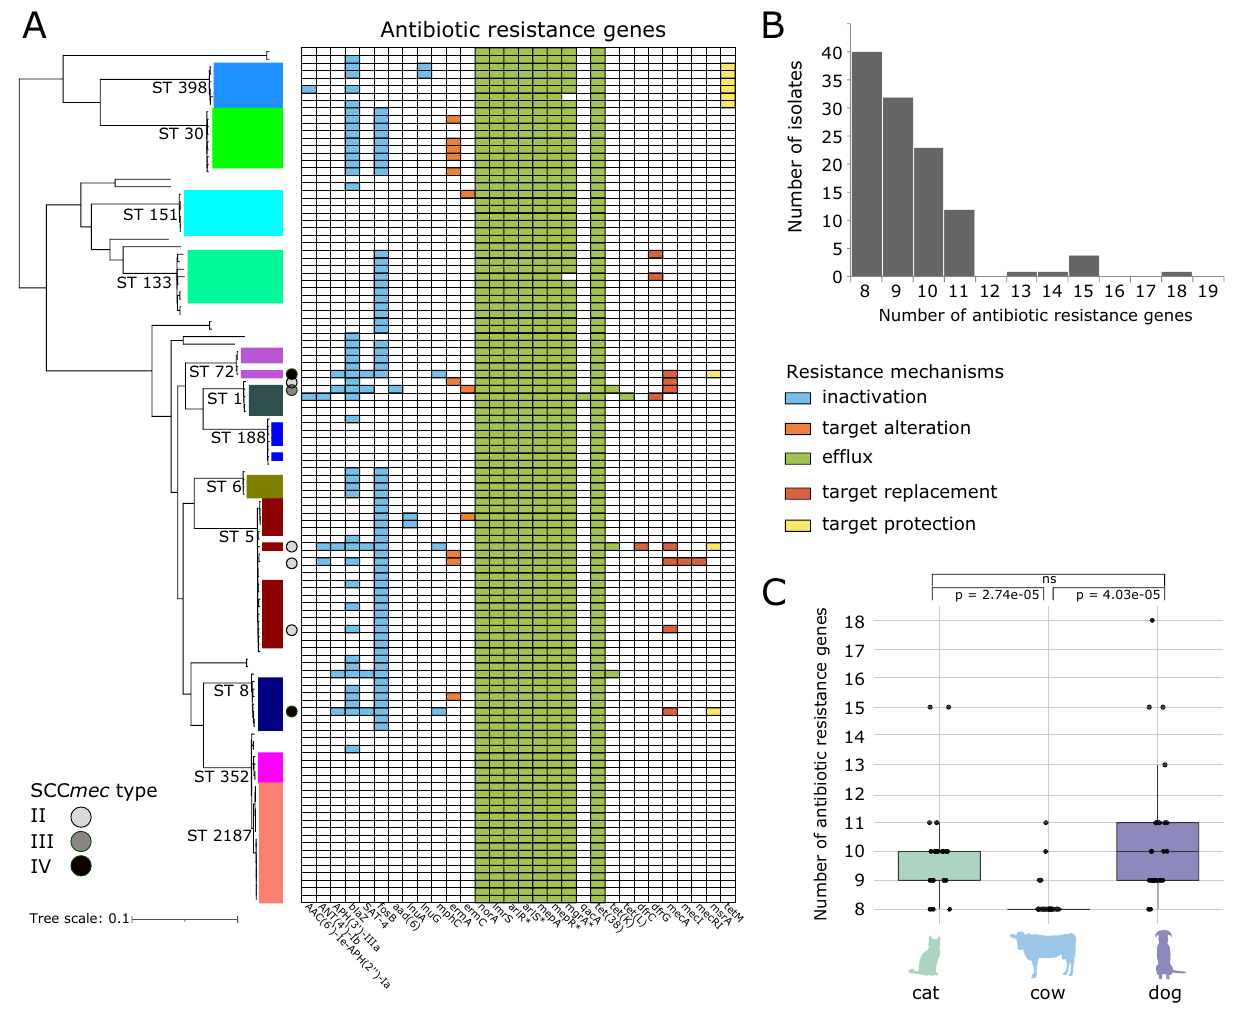
Figure 2. Antibiotic resistance profiles of animal-associated S. aureus in New England. ( A ) Distribution of acquired antibiotic resistance genes. The genes are color-coded according to resistance mechanisms. The type of SCC mec is also shown. Asterisks indicate genes associated with antibiotic resistance regulation. ( B ) Number of antibiotic resistance genes per genome. ( C ) Comparison of number of resistance genes per S. aureus genome in cats, cows and dogs. Significance was estimated using Welch’s